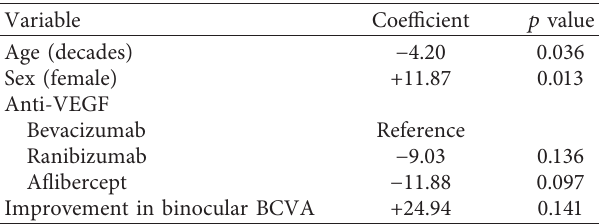
Table 3: Final fitted multivariate regression model.